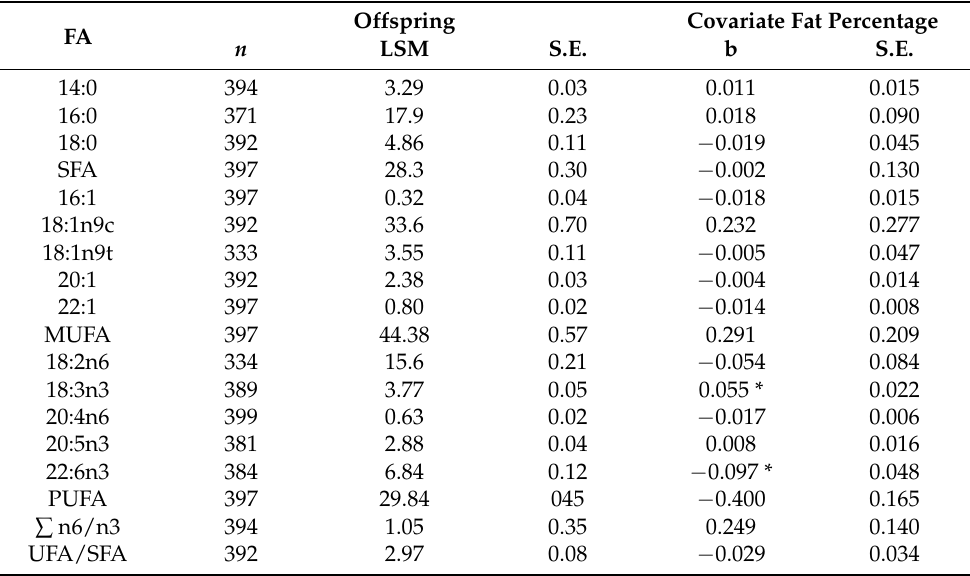
Table 3. Main fatty acids (FA, expressed as %) of gilthead seabream flesh adjusted to 10.1 fat percentage.